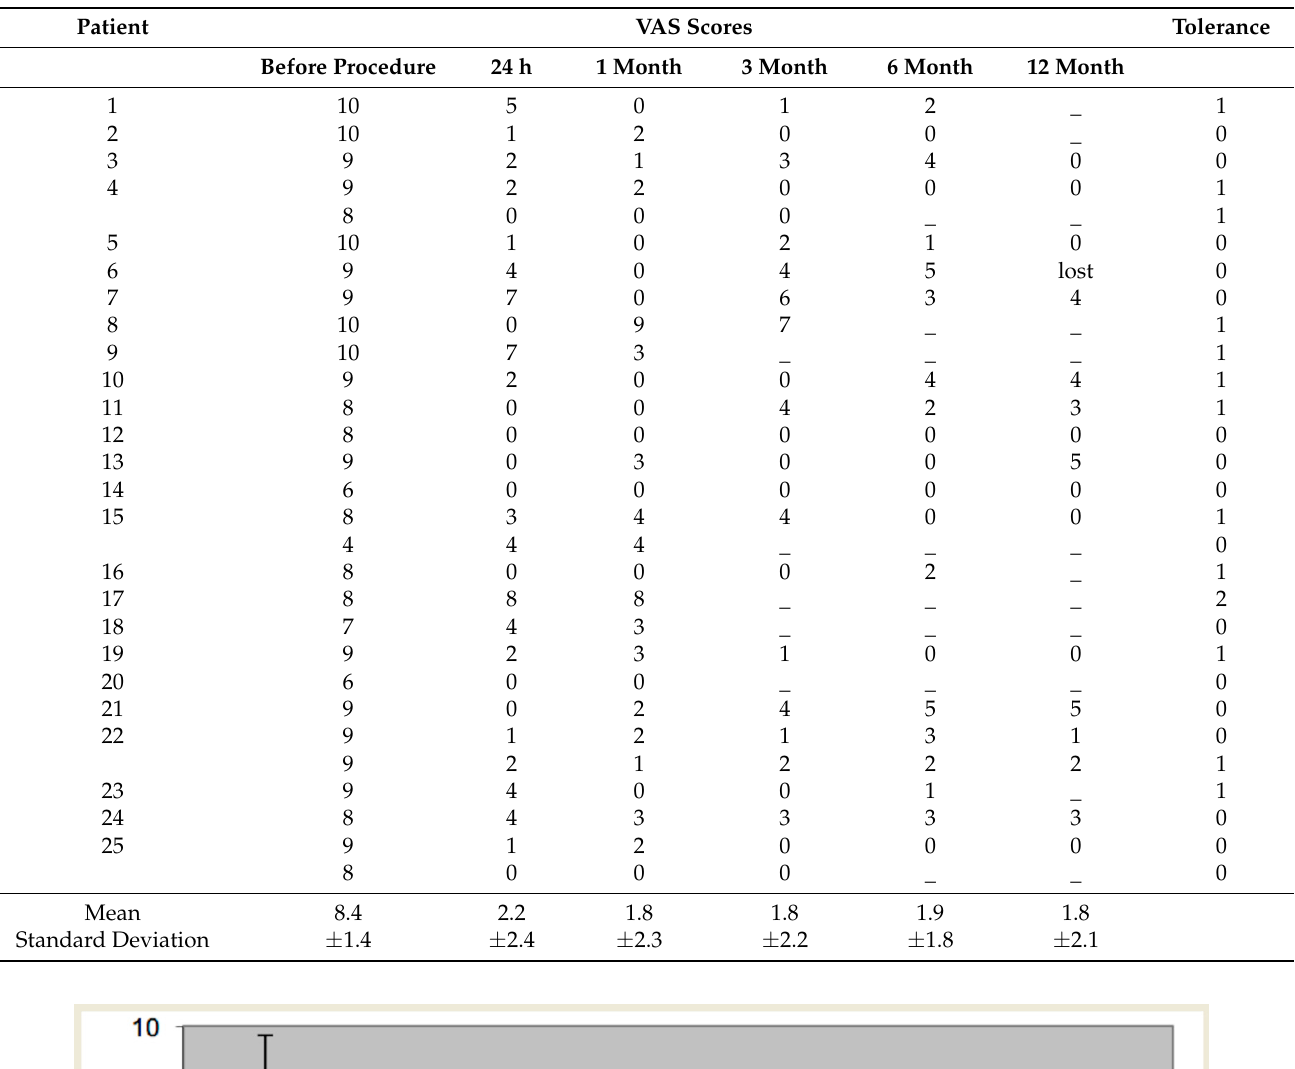
Table 2. Detailed VAS follow-up data.